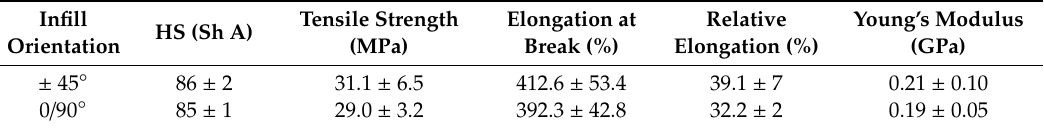
Table 4. Results of hardness and tensile strength test. The conditions of test sample printing are shown in the supplementary